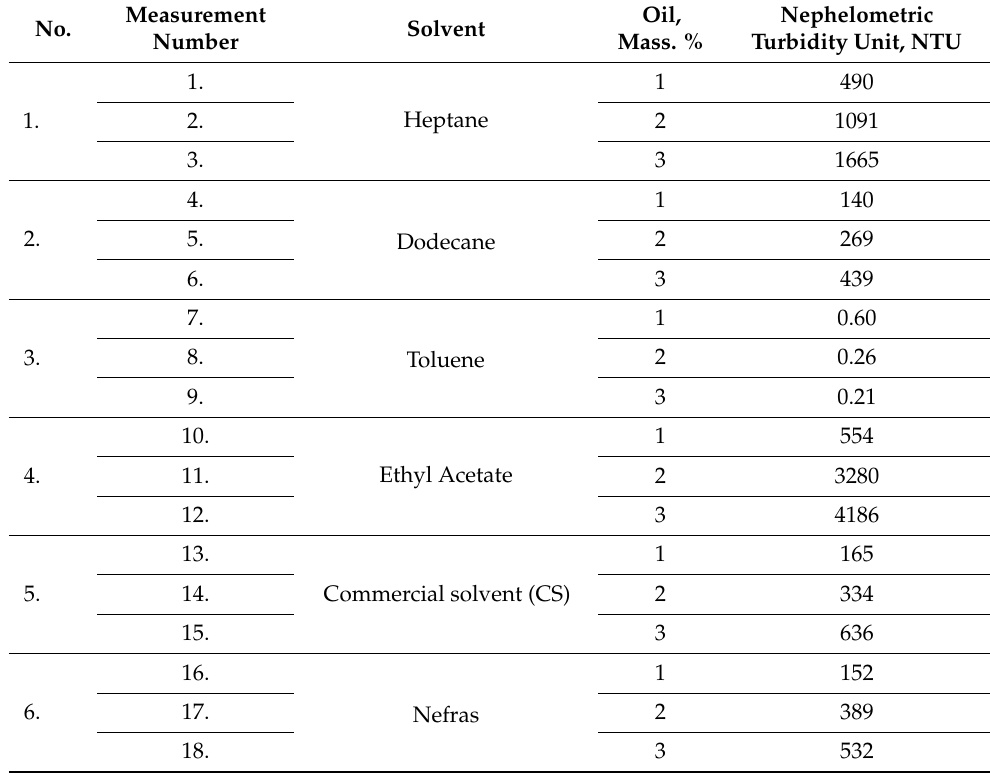
The obtained results from turbidity measurements are presented in Table 5. Two areas were distinguished for all of the investigated solutions: oil solutions (3% wt.) with NTU ≤ 1.1 and oil solutions (3% wt.) with NTU ≥ 91. The following criteria were estab- lished to assess the oil/solvent stability: (1) NTU ≤ 1—effective solvents recommended for Table 4. Changes in the oil viscosity dynamics in the presence of different solvents. use; (2) NTU ≥ 50—ineffective solvents not recommended for further tests. Table 5. Experimental values of the oil solution turbidity in various solvents and their mixtures.